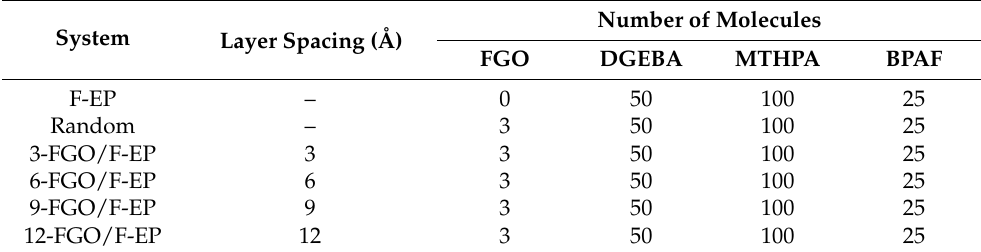
Figure 1. Establishment of molecular models. ( a ) Monomer molecular models of DGEBA, BPAF, MTHPA, GO, and FGO. ( b ) Model of F-EP filled with FGO. ( c ) Crosslinking procedure. Table 1. Composition of FGO modified F-EP